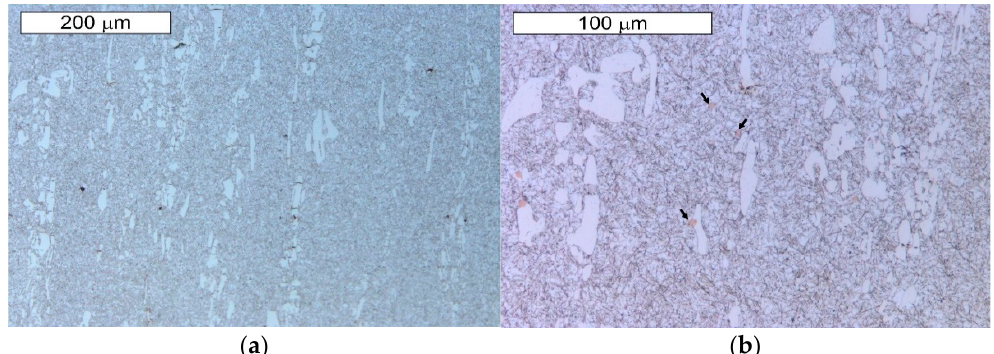
Figure 11. Microstructure of the examined steel X153CrMoV12 obtained from sample 1: ( a ) visible primary carbide precipitations arranged according to the plastic working direction in the martensitic matrix; ( b ) magnified fragment of the area from Figure 11a. Visible single nitride precipitations in the microstructure of the material (marked with an arrow). Light microscopy, etched state.